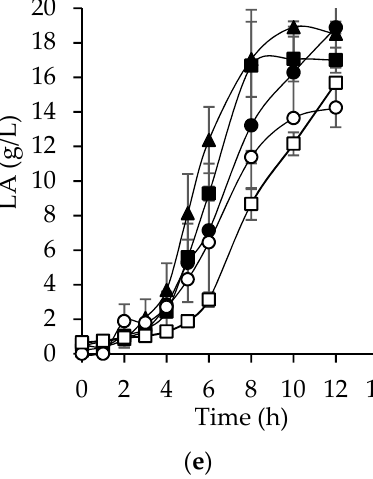
Figure 4. Kinetic profiles for biomass ( a ), hyaluronic acid ( b ), glucose ( c ), mannose ( d ), and lactic acid ( e ) from batch fermentation with S. zooepidemicus from hydrolyzates: ( ● ) acid hydrolysis (AcH), ( ○ ) acid hydrolysis of extracted bored-coffee beans (AcHD), ( ■ ) enzymatic hydrolysis (EnH), ( □ ) enzymatic hydrolysis of extracted bored-coffee beans, and ( ▲ ) synthetic medium. Bars represent ± standard deviation (n = 2). Table 5. Kinetic parameters and concentration of products for the production of hyaluronic acid from different hydrolyzates.